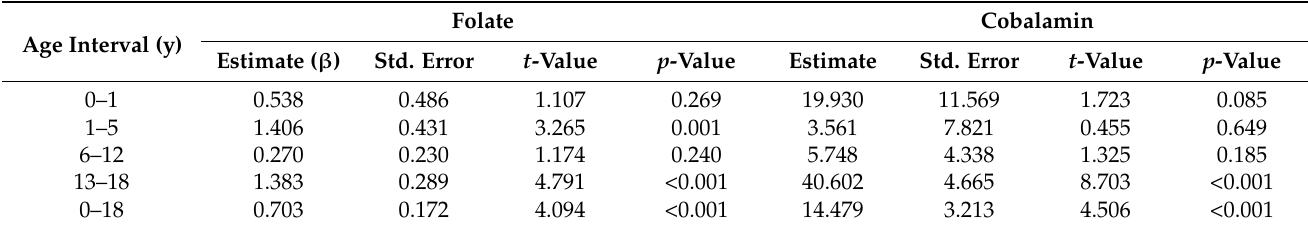
Table 3. Multivariate regression analysis results: sex stratified by age.